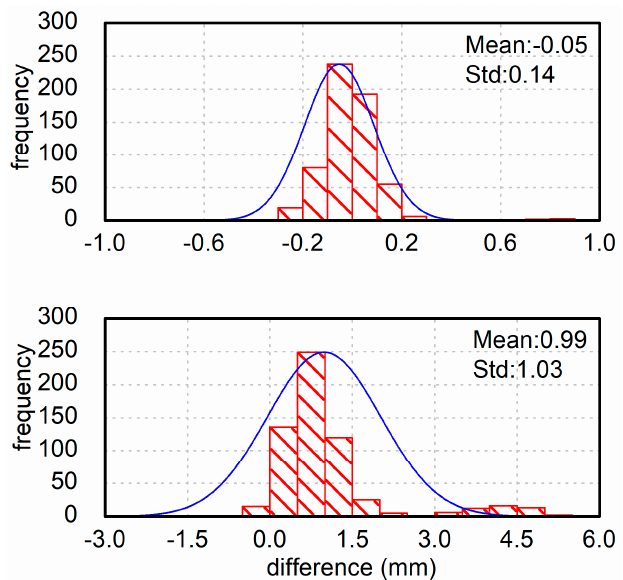
Figure 5. The distributions of ZWD differences for station YKRO during daytime ( top ) and night-time ( bottom ) on DOY 239 in 2017. The y-label “frequency” signifies the number of collected differences. The mean values and standard deviations of ZWD differences are shown in the top right corner of each figure.